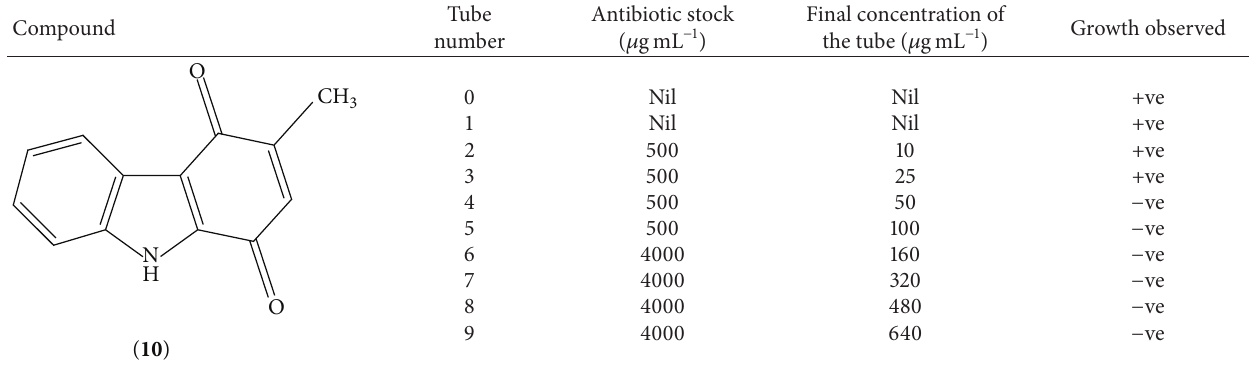
Table 3: Result of MIC determination of compound 10 .